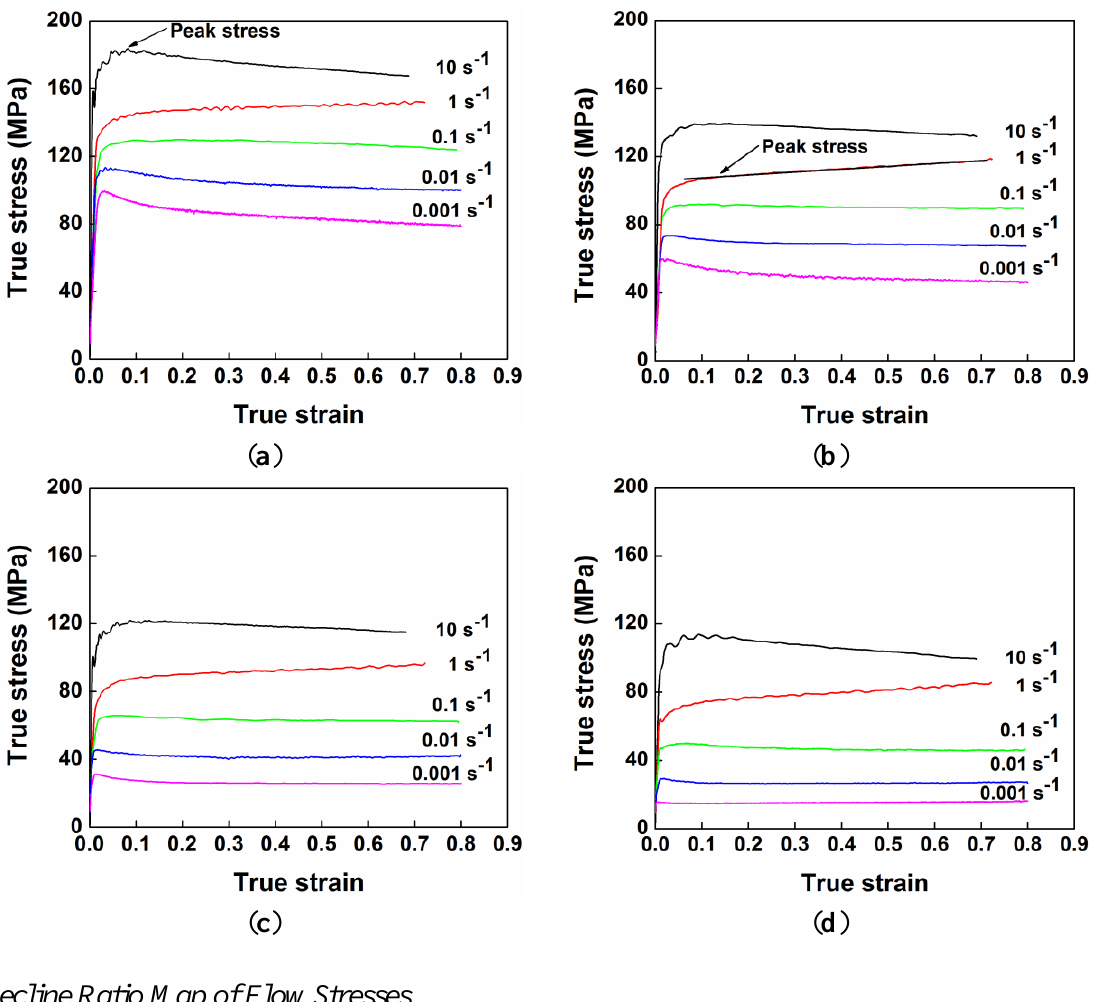
Figure 2. True stress-true strain curves of the alloy during hot compression